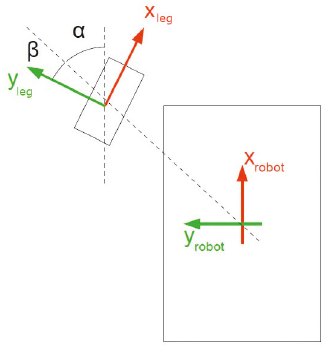
Figure 10. Representation of parameters used in the kinematics for a leg.